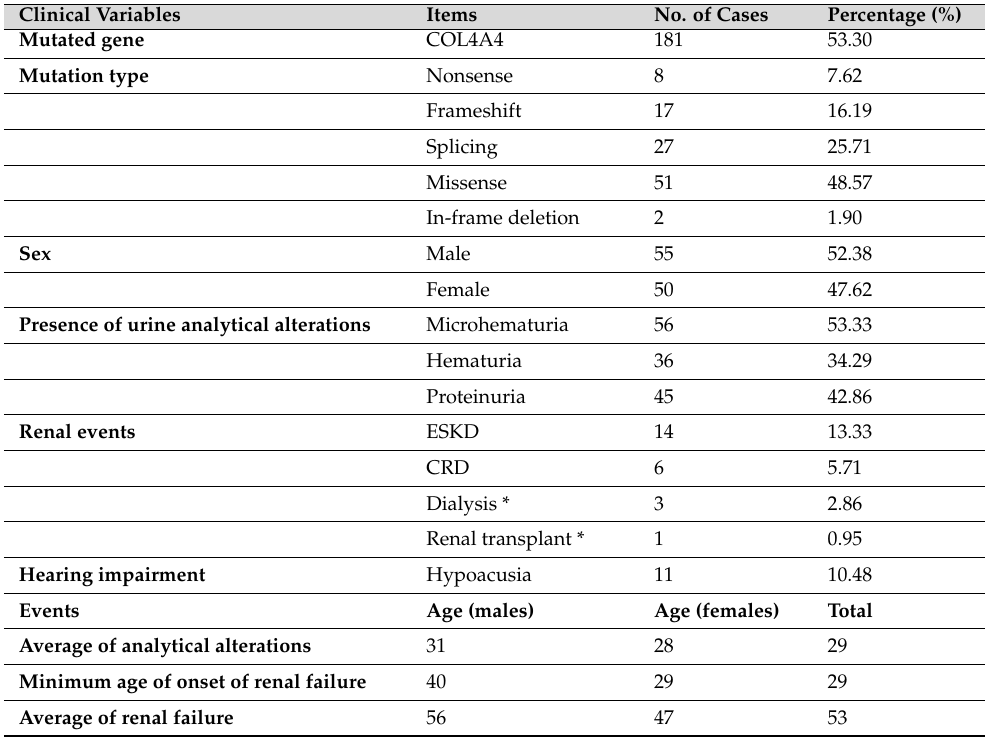
Table 2. A summary of the clinical data on patients with heterozygous deleterious mutations in COL4A4